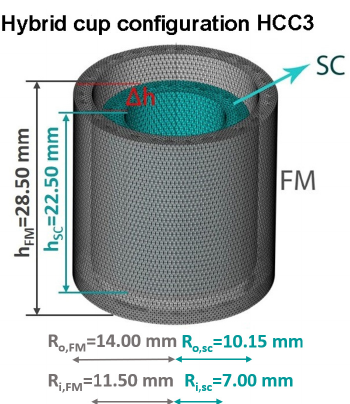
Figure 9. Schematic view of the hybrid layout HCC3 consisting of two SC/FM superimposed cups with the FM cup protruding above the SC one. The shield sizes are reported in the picture, where R o and R i are the outer and inner radii of the cup layouts, respectively; the base thickness of the SC cup is 4.20 mm, while base thickness of the FM cup is 2.50 mm; ∆ h = 3.5 mm represents the height difference between the cup